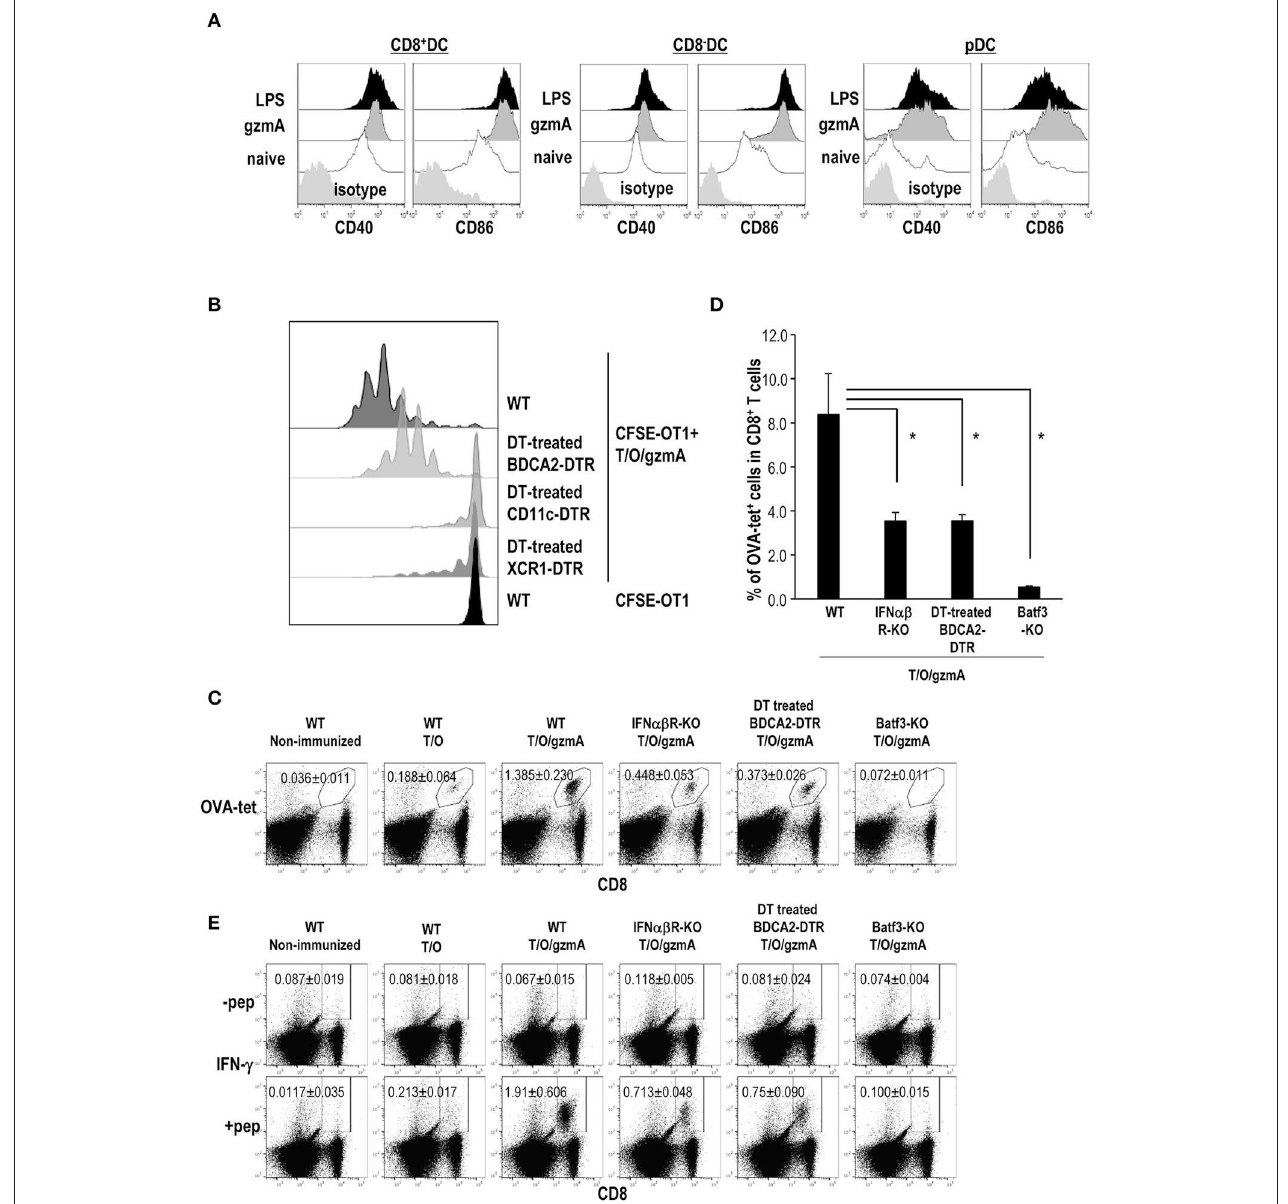
FIGURE 7 | GzmA-stimulated pDCs promote XCR1 + DCs to cross-present antigen to CD8 + T cells. (A) In vivo DC maturation by GzmA. Mice were injected intravenously with GzmA (20 µ g/mouse) or LPS (20 µ g/mouse). Sixteen h later, splenic DC subsets (CD8 + or CD8 − cDCs and pDCs) were analyzed for expression of maturation markers CD40 and CD86 by flow cytometry. ( n = 5) (B) Cross-presentation of antigen by DCs in vivo . BDCA2-DTR, CD11c-DTR and XCR1-DTR mice were treated with DT at day-2, − 1, 0, and 1. Mice were administered with 1 × 10 6 CFSE-labeled OT-1 cells at day-1 and then immunized with cell-associated OVA (T/O) together with GzmA at day 0. Three days later, OT-1 proliferation was monitored in spleen cells by CFSE dilution. Data are representative of two independent experiments ( n = 3). (C–E) Antigen specific CD8 + T cell response. As shown in (B) , but in this case the immune response was measured in naïve mice and several KO mice immunized i.v. with T/O cells together with or without GzmA. In some experiments, BDCA2-DTR mice were treated with DT. The frequency of CD8 + T cells bearing a TCR specific for an OVA-H-2K b tetramer (C,D) and IFN- γ production by OVA-specific CD8 + T cells (E) in spleen were analyzed by flow cytometry on day 7. All data in (C–E) are representative of two independent experiments with similar results (mean ± SEM, n = 4). * < p < 0.05 (WT vs. others, Steel’s Many - one Rank Sum